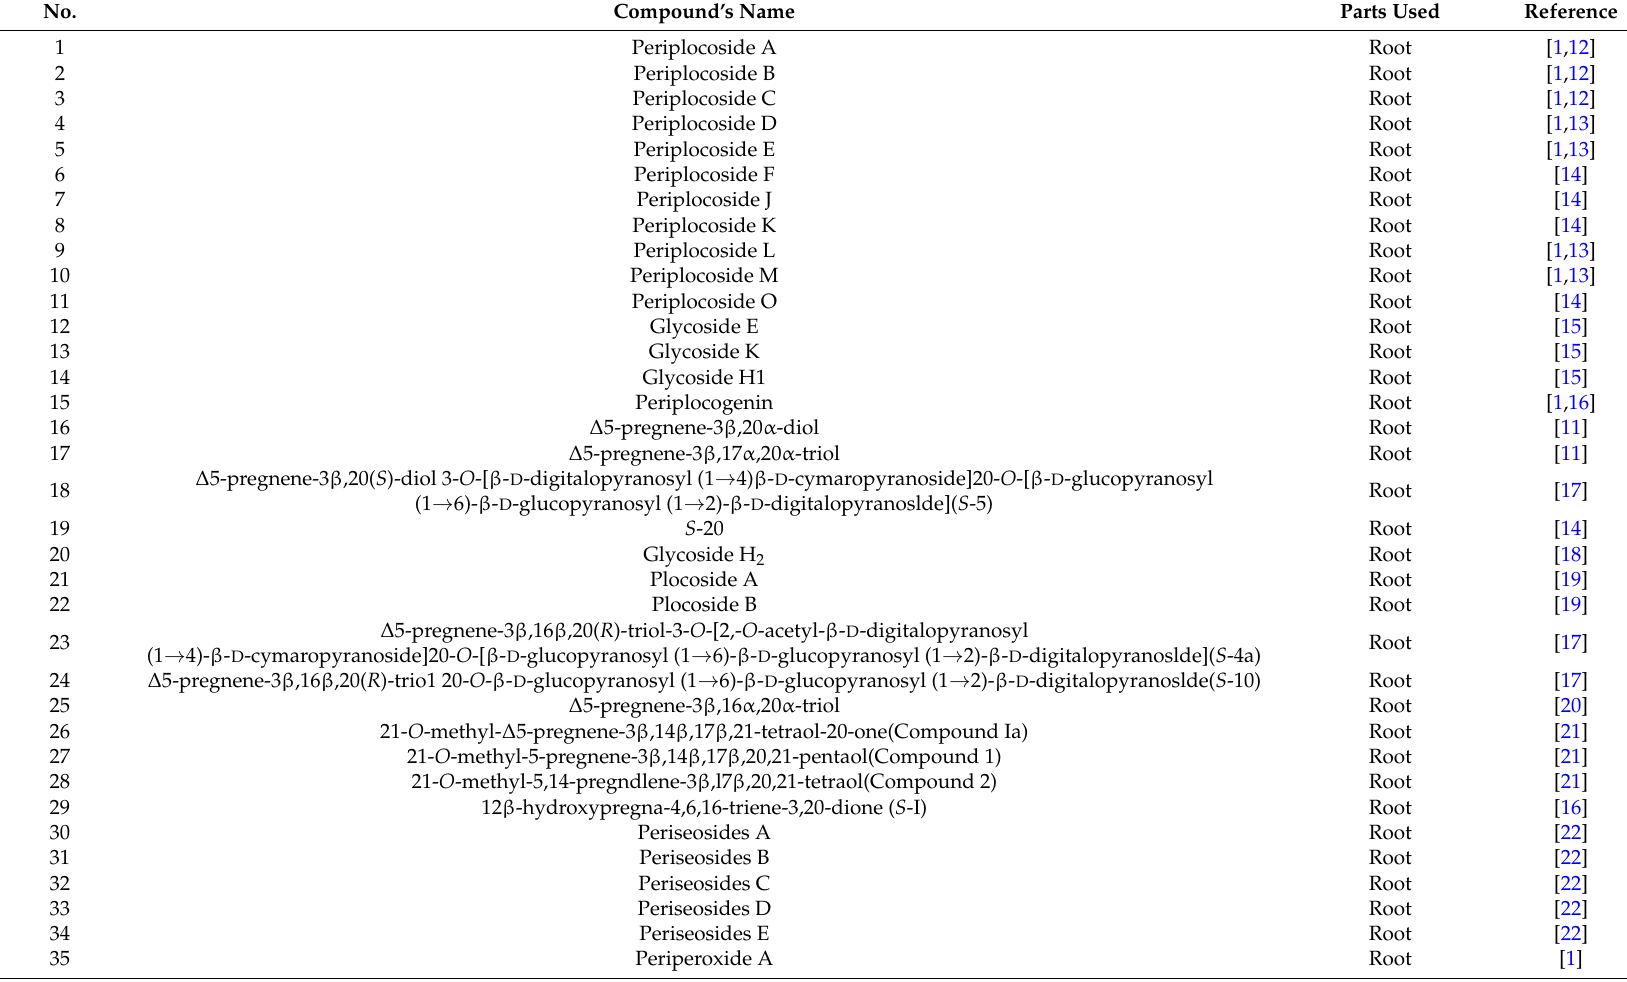
Table 1. C 21 -steroidal glycosides from Cortex Periplocae (1–35).